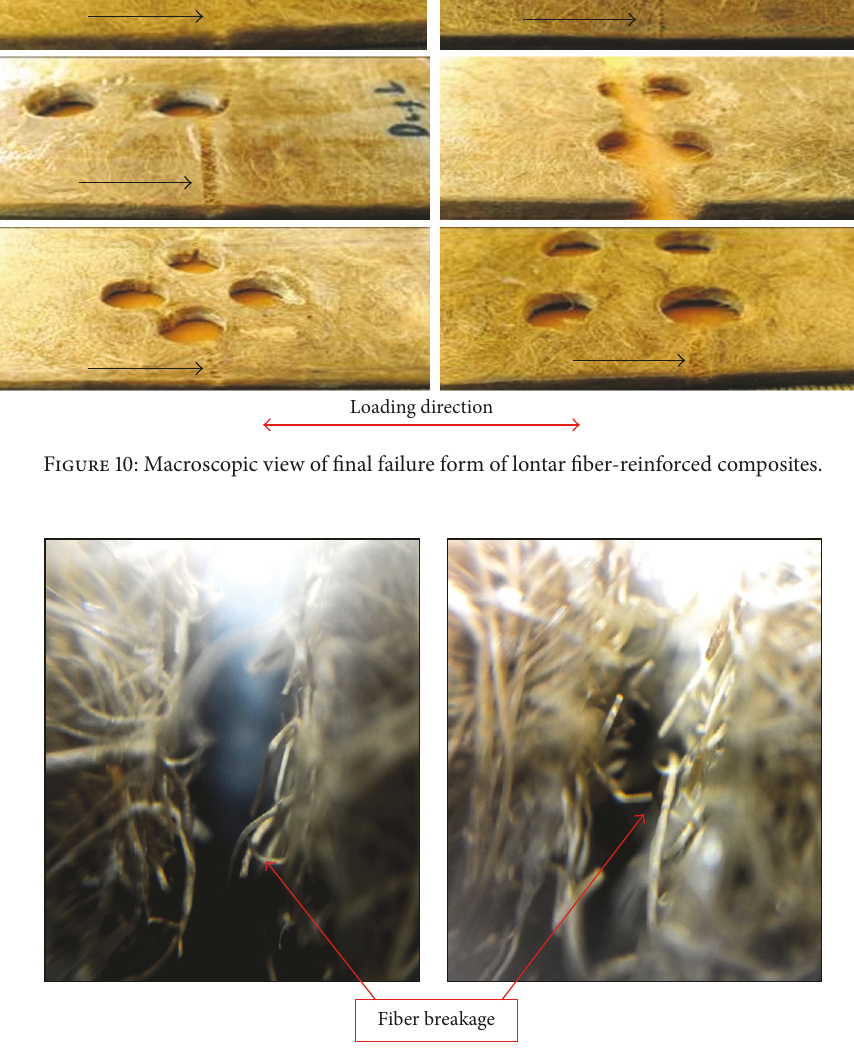
Figure 11: Macroscopic view of final failure form of lontar fiber-reinforced composites